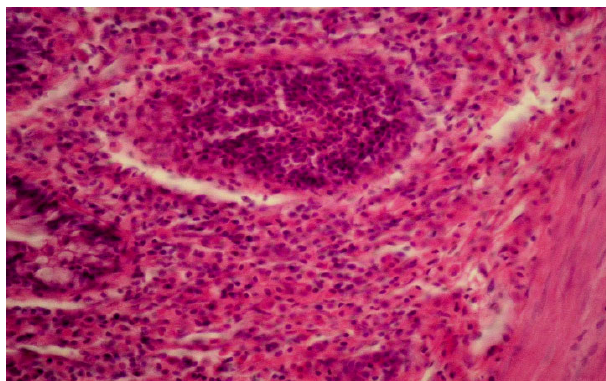
Fig. 5. Lymphoid nodule in the submucosal layer of carp intestine in Experiment 3. H&E. x 200